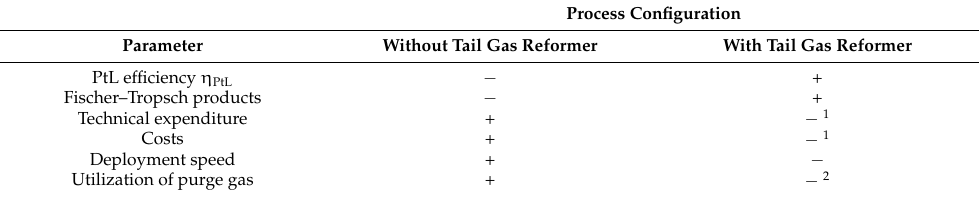
Table 7. Performances and feasibility of pilot scale plants producing synthetic fuels and wax with and without implementing a tail gas